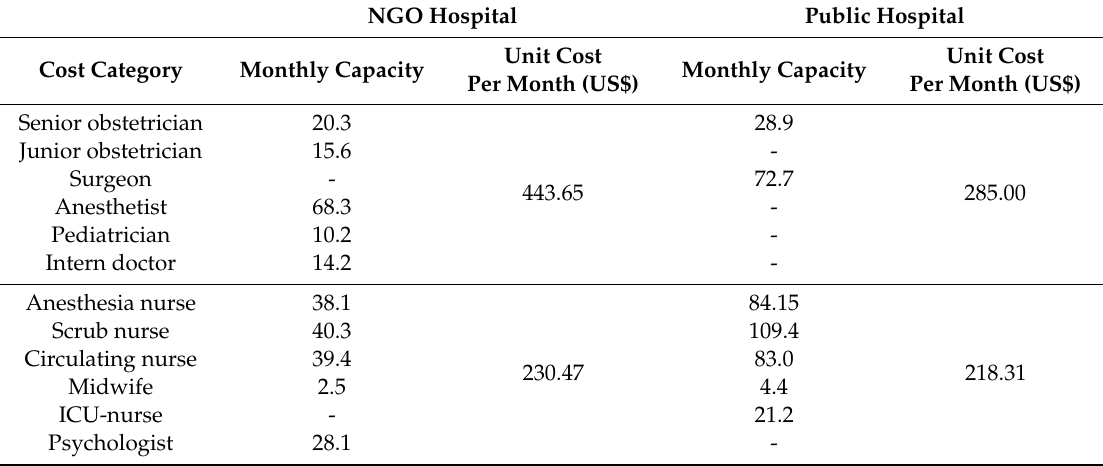
Table 5. Monthly treatment capacities and unit costs per sta ff member.